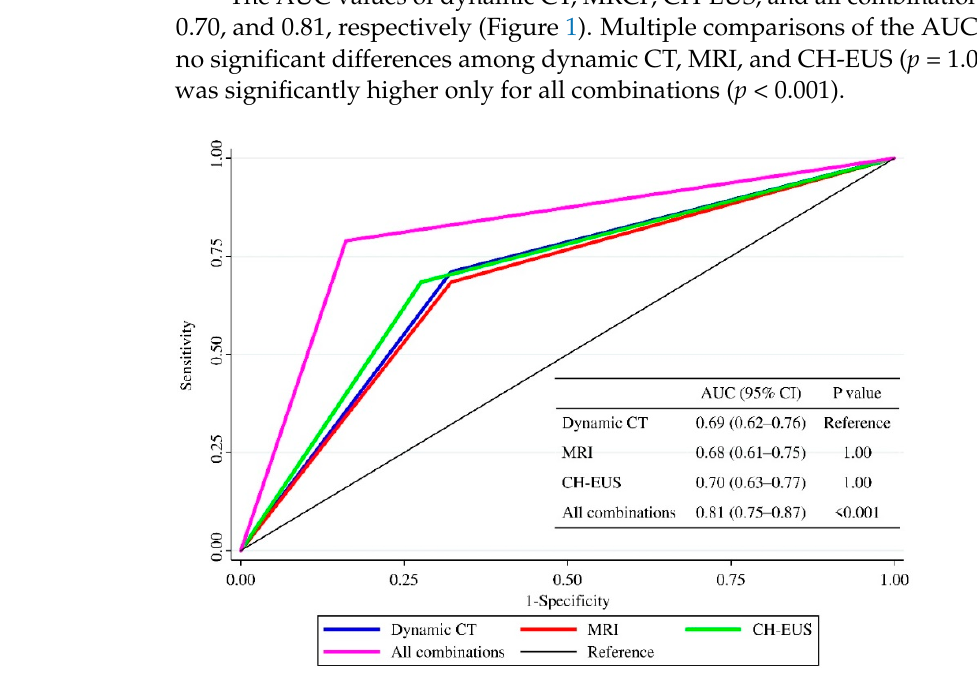
Figure 1. Comparison of the diagnostic performance among dynamic CT, MRCP, CH-EUS, and all combinations (i.e., CH-EUS, dynamic CT, and MRI) using Bonferroni correction (n = 301) during complete case analysis.